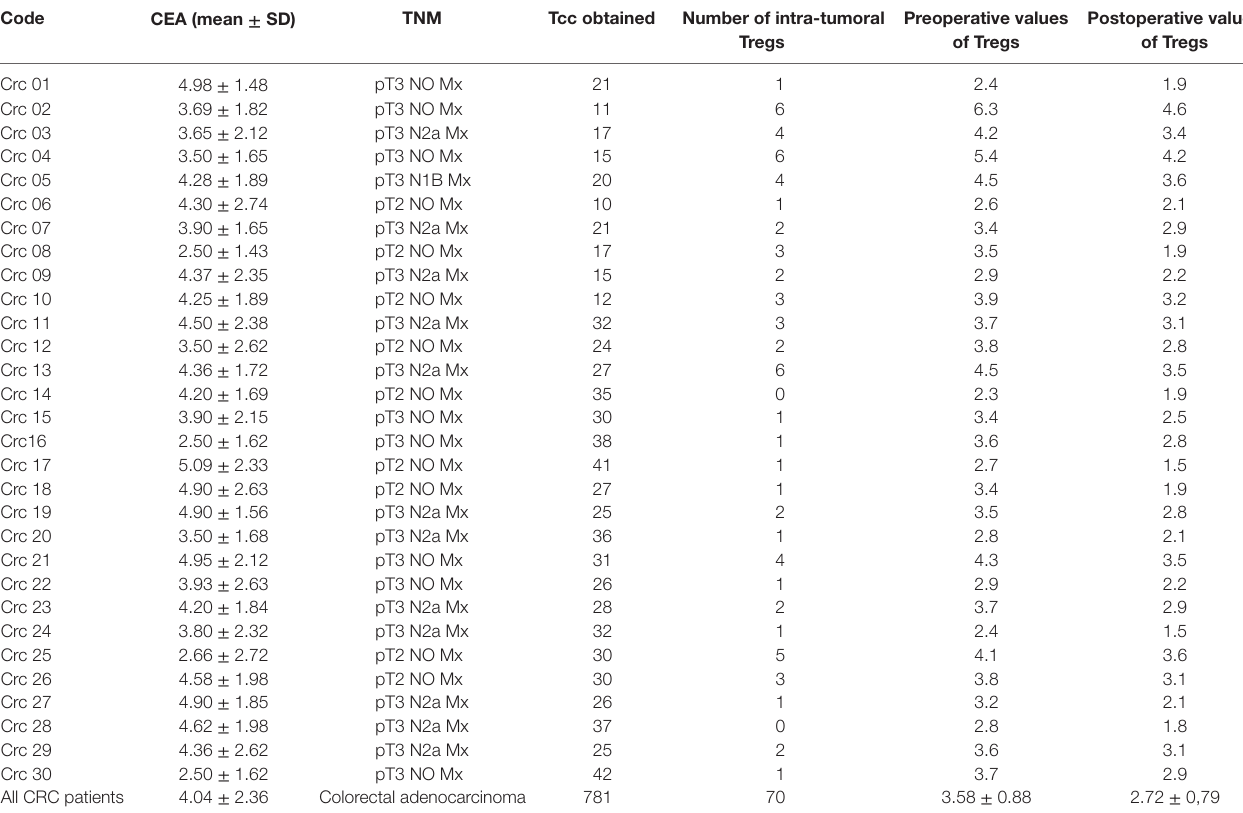
Table 1 | Clinical characteristics of colorectal cancer (CRC) patients: T cell clones (Tcc) generated and pre/postoperative values of circulating CD4 + regulatory T cells (Tregs).